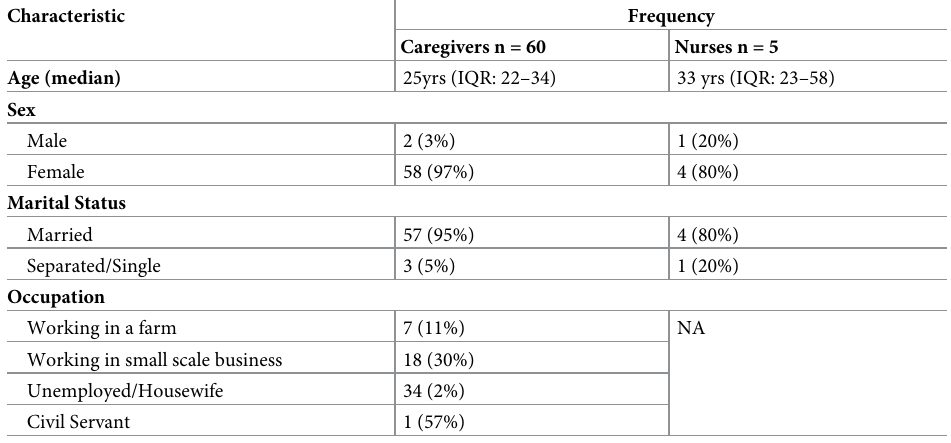
Table 1. Demographic characteristics of study